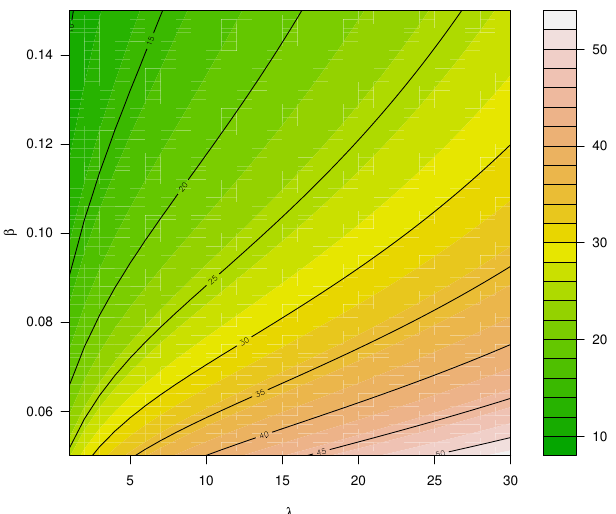
Figure A2. Dispersion index for X ∼ PncLI( β , λ ) for different values of ( β , λ